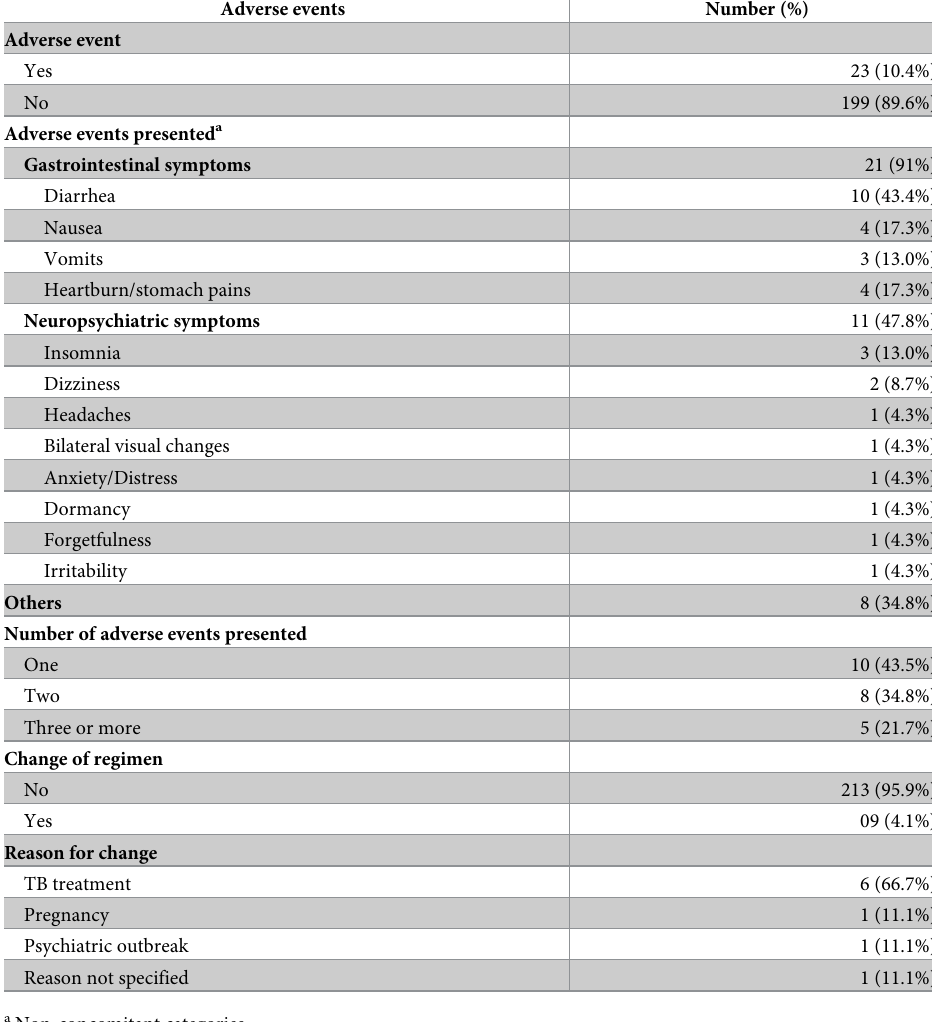
Table 2. Adverse events after introducing the first antiretroviral regimen containing